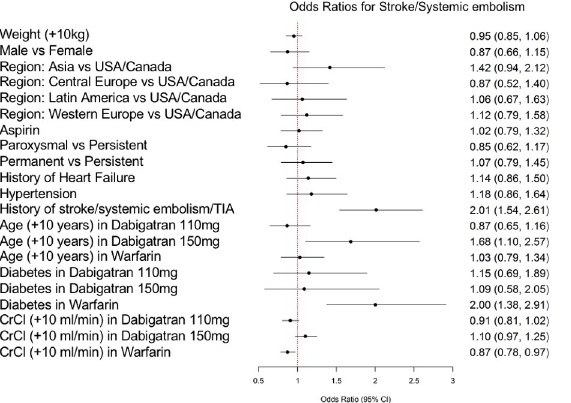
Fig 1. Risk prediction model for stroke or systemic embolism. Shown are the odds ratio (OR) and 95% confidence interval (CI) for each variable. For variables with interactions with treatment assignment, ORs are presented separately for treatment with dabigatran 110mg, dabigatran 150mg, and warfarin. CI, confidence interval; CrCl, creatinine clearance; TIA, transient ischemic attack; USA, United States of